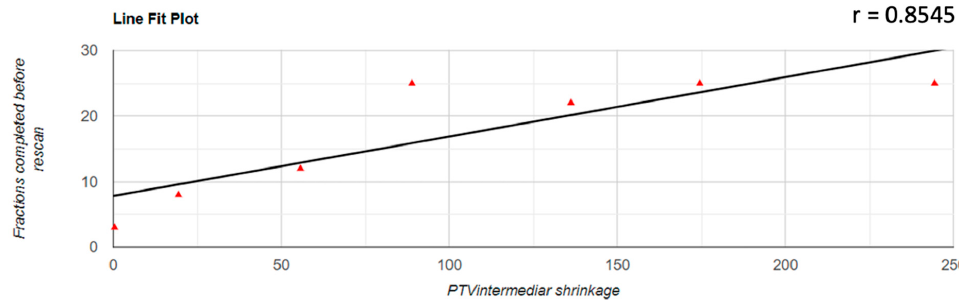
Figure 4. Graphical representation of the PTVintermediate reduction in correlation with the number of fractions completed before replanning.